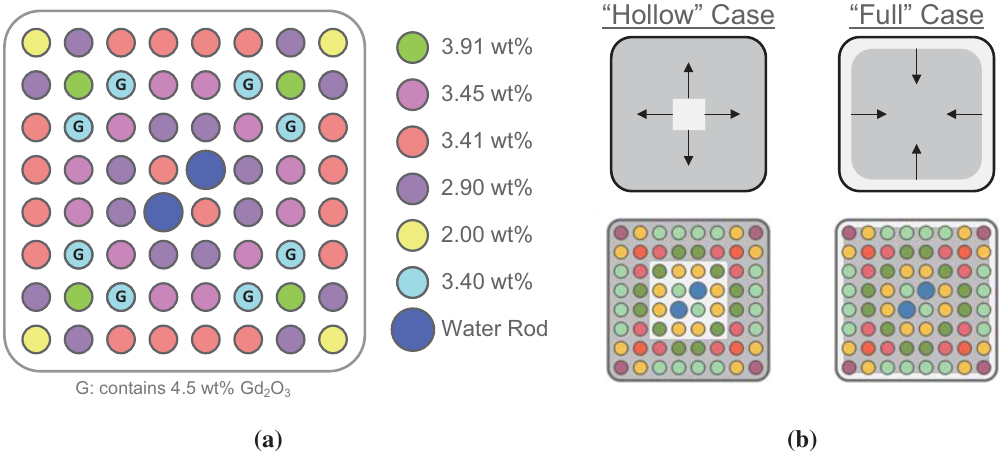
Figure 1: (a) Radial enrichment layout of Fukushima Daini 2: assembly 2F2DN23. (b) Graphical depiction of hypothetical cases with sample geometries to show how void is represented in each case. Dark shades indicate areas of liquid while lighter shades indicate areas of